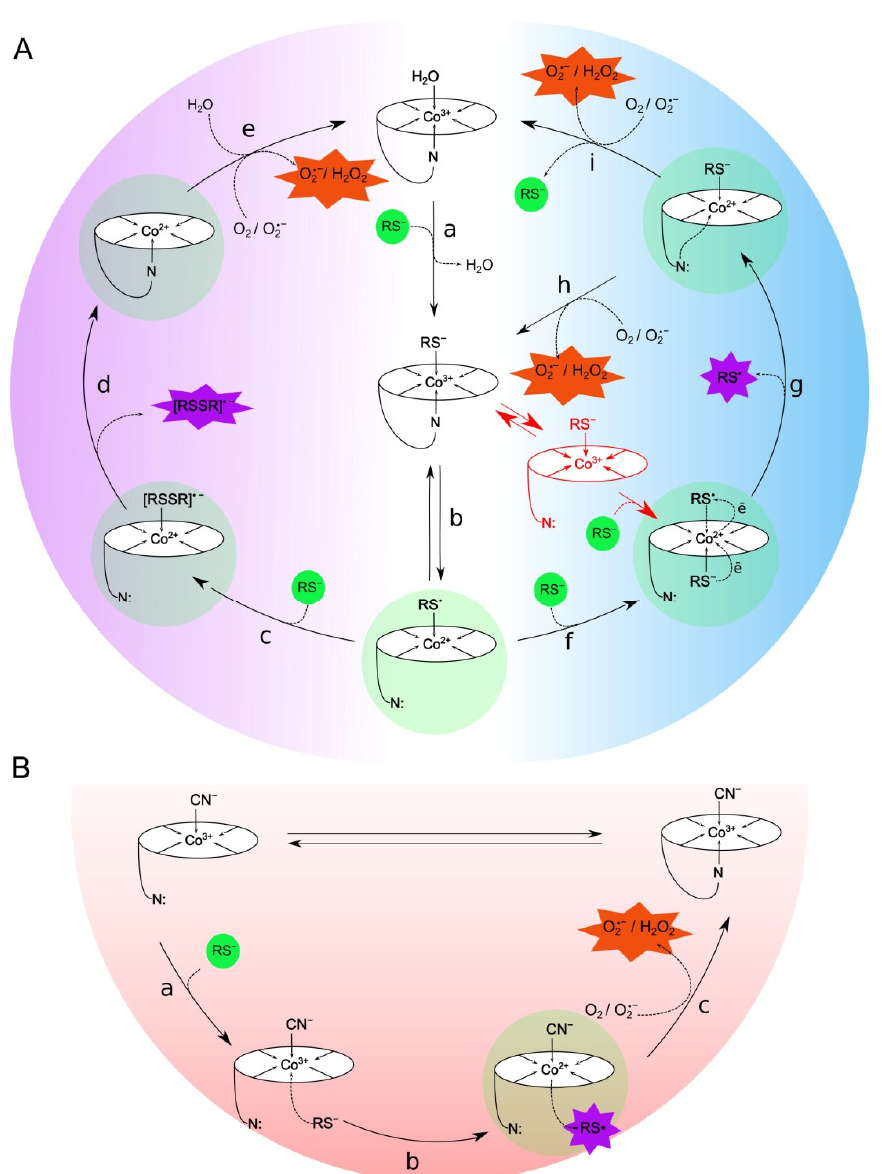
Figure 7. The proposed mechanism for the oxidation of thiols catalyzed by cobalamins. ( A ) H 2 OCbl + /HOCbl. The structure shown in red is a possible intermediate formed during the reaction [49]. ( B ) CNCbl. GSH, NAC, and DTT predominantly occur in the protonated form (RSH) at physiological pH. When thiol coordinates to cobalamin, deprotonation and complex formation between RS − and Cbl occur. TNB predominantly exists in the anionic form (RS − ) at physiological pH.